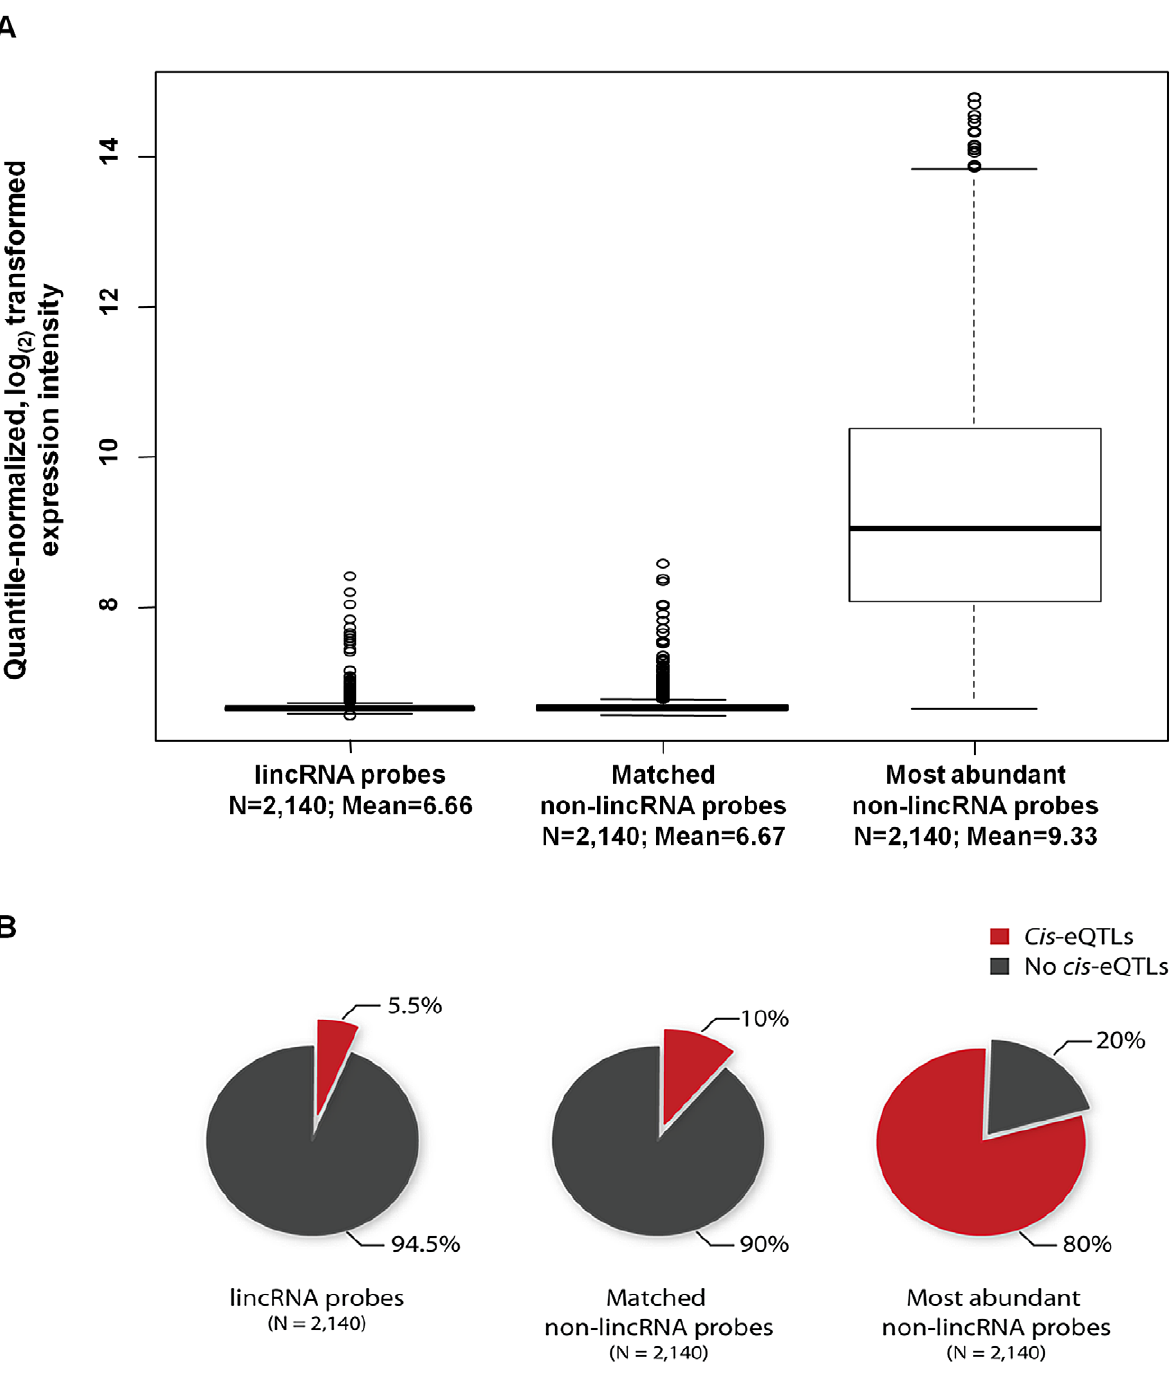
Figure 1. The number of detected cis -eQTLs is dependent on the expression levels of the transcripts. (A) Quantile-normalized average expression intensity and (B) number of cis -eQTL affected probes in percentage, for 2,140 lincRNA probes, 2,140 non-lincRNA (matched for 2,140 lincRNA probes’ median expression and standard deviation) and 2,140 most abundantly expressed non-lincRNA probes. doi:10.1371/journal.pgen.1003201.g001 standard deviation), using the same 1,240 blood samples mapped cis -eQTLs for an equal set of 2,140 probes that were instead protein-coding and were the most abundantly expressed of (Figure 1A). We indeed observed a profound relationship between all protein-coding probes. We also conducted cis -eQTL mapping average expression levels of protein-coding transcripts and the for a set of 2,140 protein-coding probes that had been selected to number of detectable cis -eQTLs. Eighty percent of the 2,140 most abundantly expressed protein-coding probes showed a cis -eQTL have an identical expression intensity distribution as the 2,140 lincRNA probes (i.e. matched for mean expression intensity and effect, whereas only 10% of the protein-coding probes that had